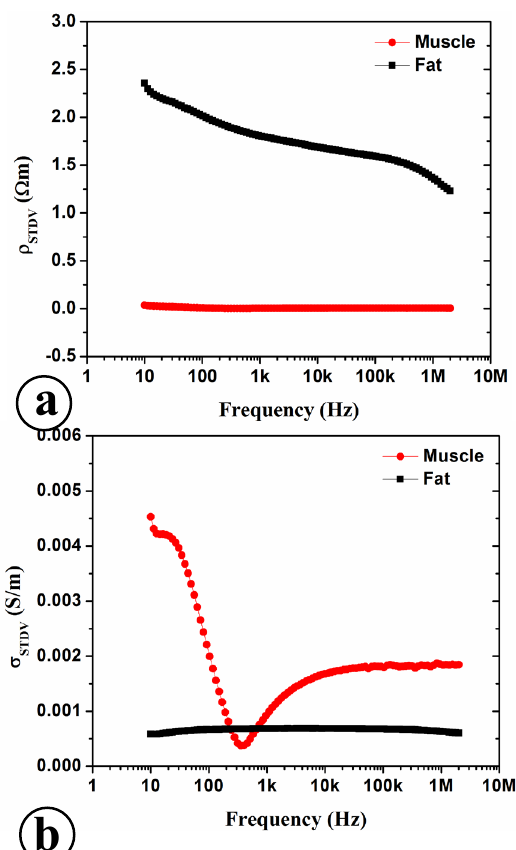
Figure-14: STDV of ρ and σ of chicken muscle tissue paste and